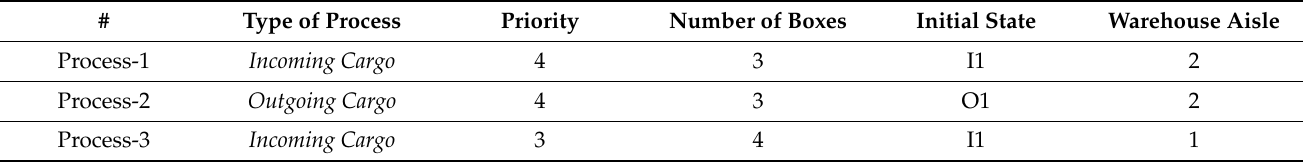
Table 3. Description of Experiment 3: Fault